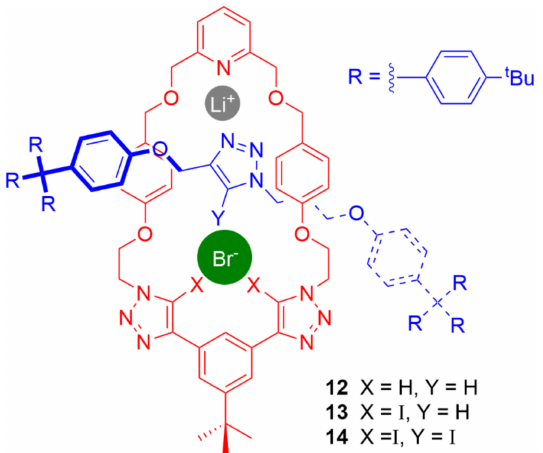
Figure 10. Beer’s active metal templated rotaxanes 12 – 14 capable of selective lithium bromide